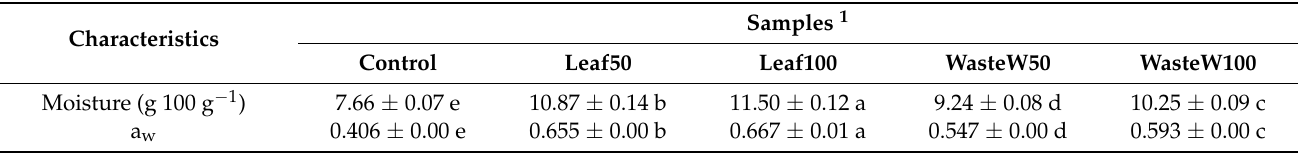
Table 2. Moisture content and a w of gluten-free (GF)